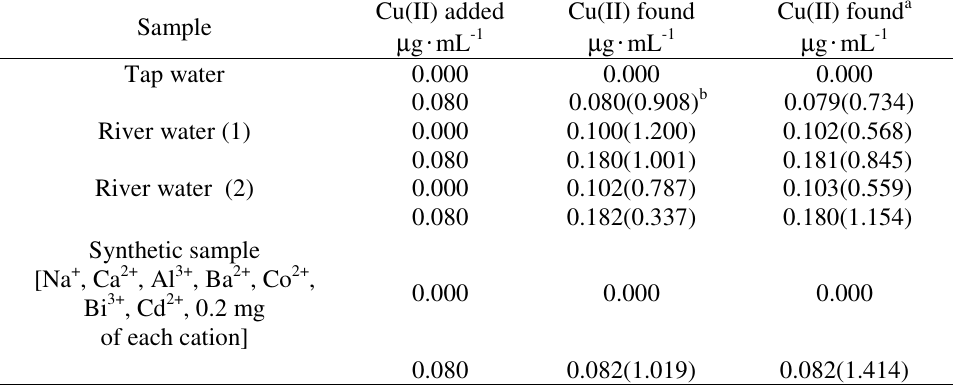
Table 3 . Recovery of copper added to 250 mL of different water